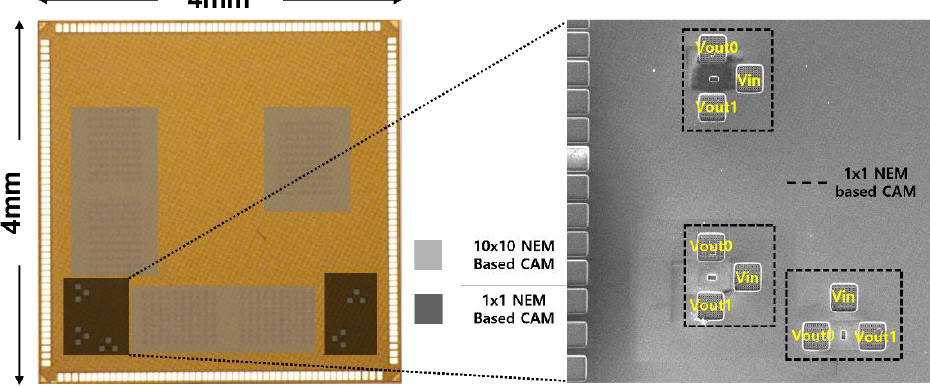
Figure 15. Die photo and 1 × 1 NEM-based CAM for movable-beam operation verification.